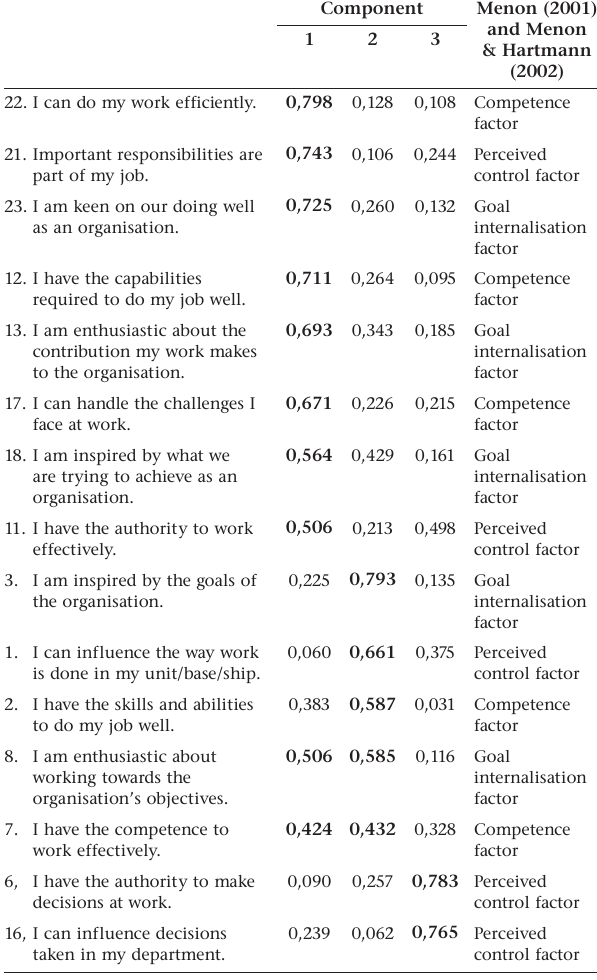
table 2 F actor analysis : three Factors speciFied and compared to previous